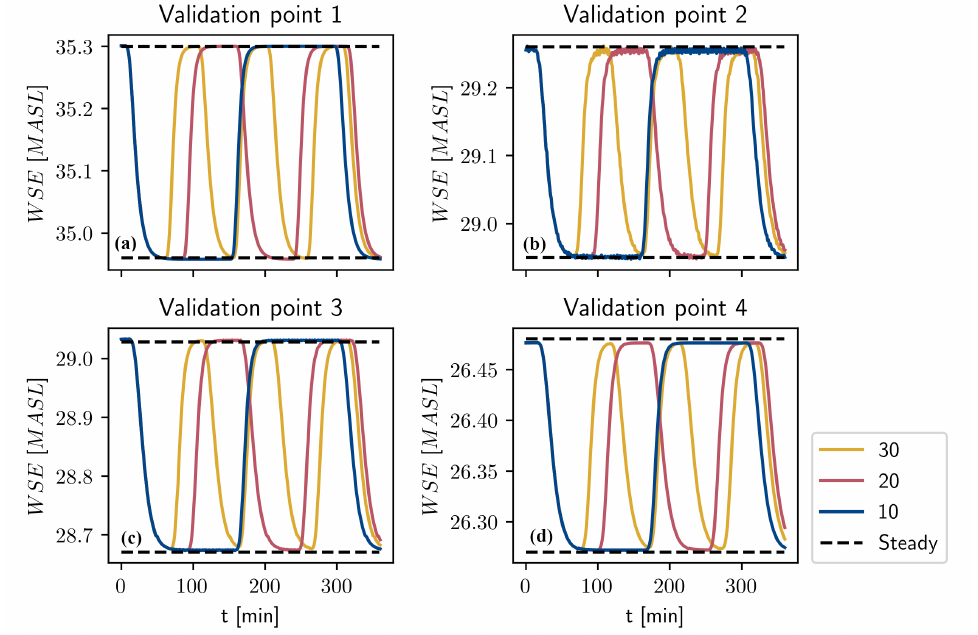
Figure 7. WSE for the points 1, 2, 3, and 4 given the flow scenarios with 10, 20, and 30 flow changes per day. ( a ) Validation point 1. ( b ) Validation point 2. ( c ) Validation point 3. ( d ) Validation point